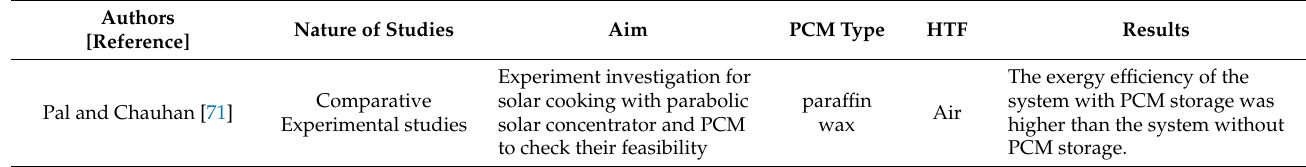
Figure 8. Parabolic solar cooker (Source: Pal and Chaun [71]). Table 7. Results of some of the studies presented on solar cooking and the PCM used.